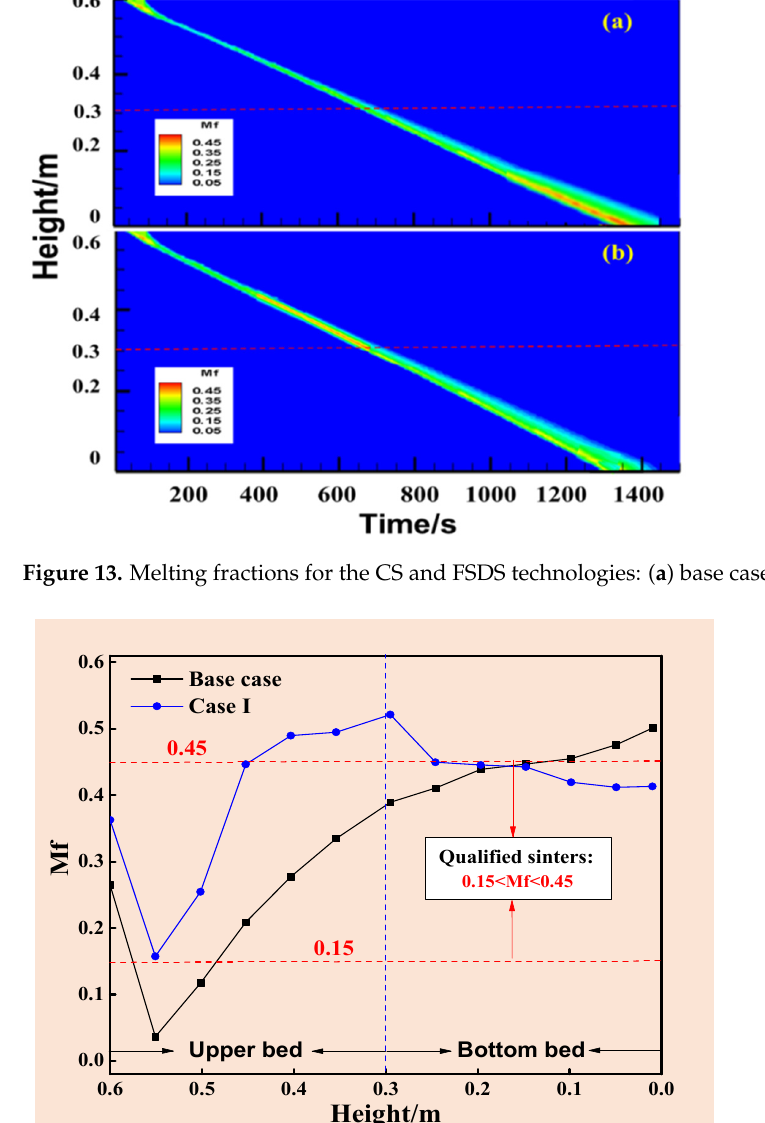
Figure 14. Mfs for CS (base case) and FSDS (case I) in sintering bed.